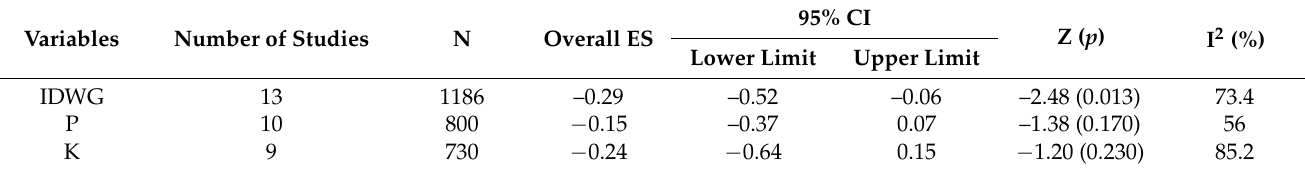
Table 6. Effects of the evaluated interventions on secondary